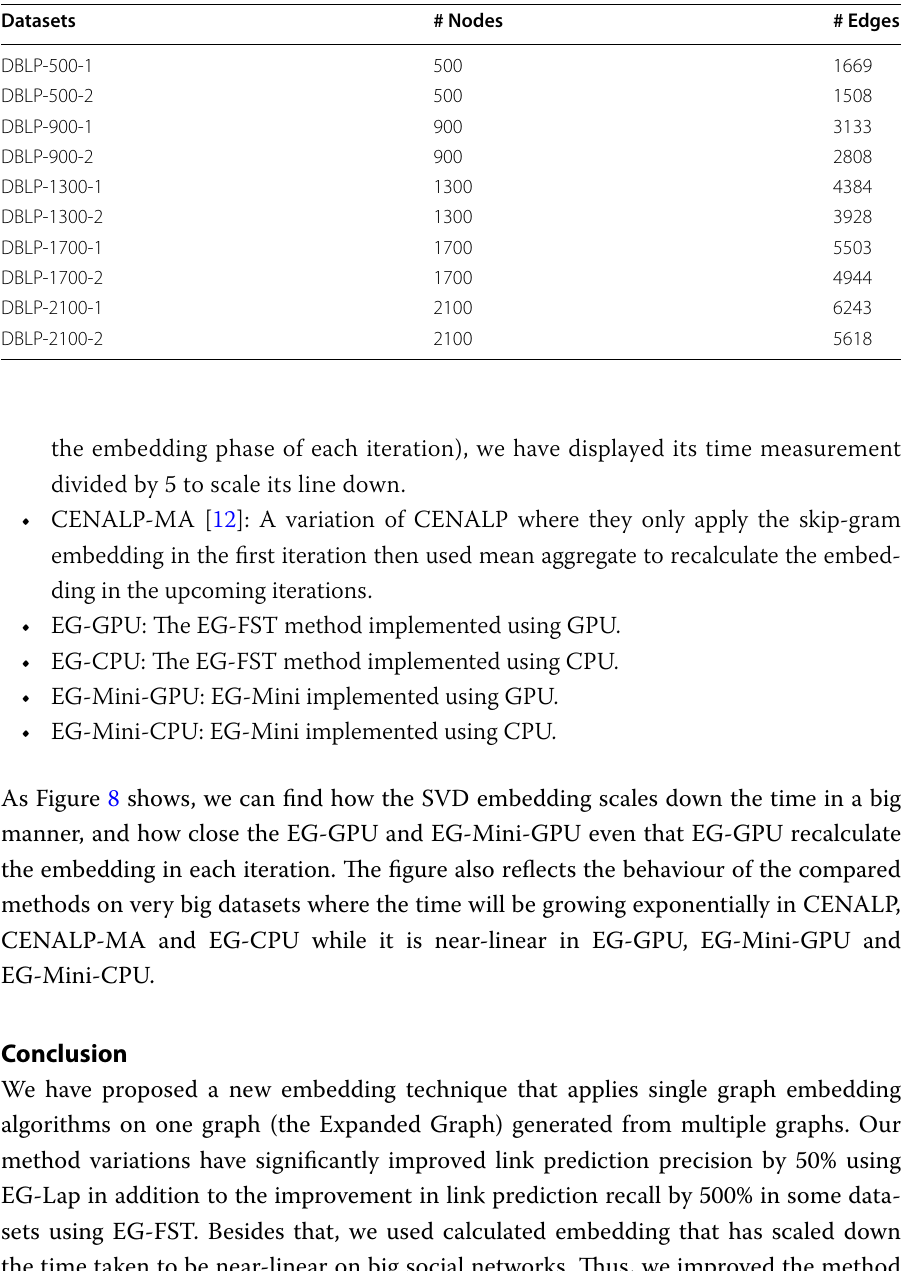
Table 2 Statistics of Datasets used in time